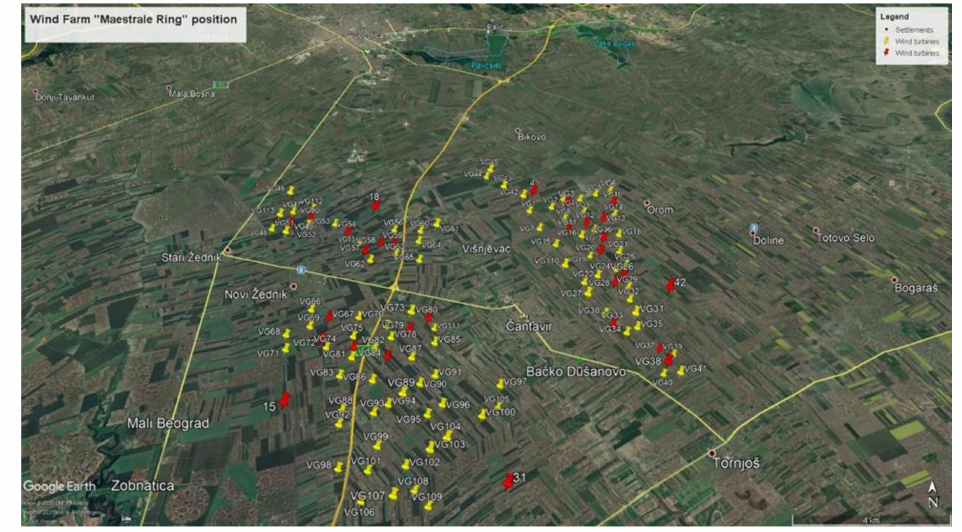
Figure 1. Position and spatial organization of the planned Maestrale Ring wind farm. (Source: Google Earth with